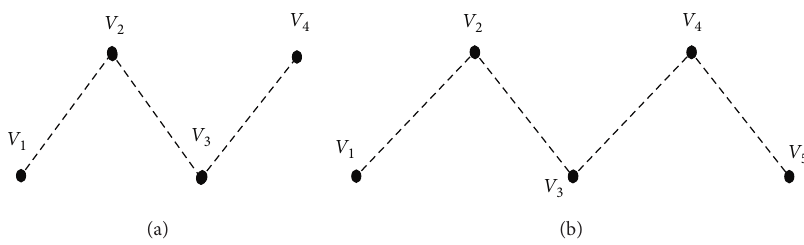
Figure 5: (a) A P section of length three. (b) A P section of length